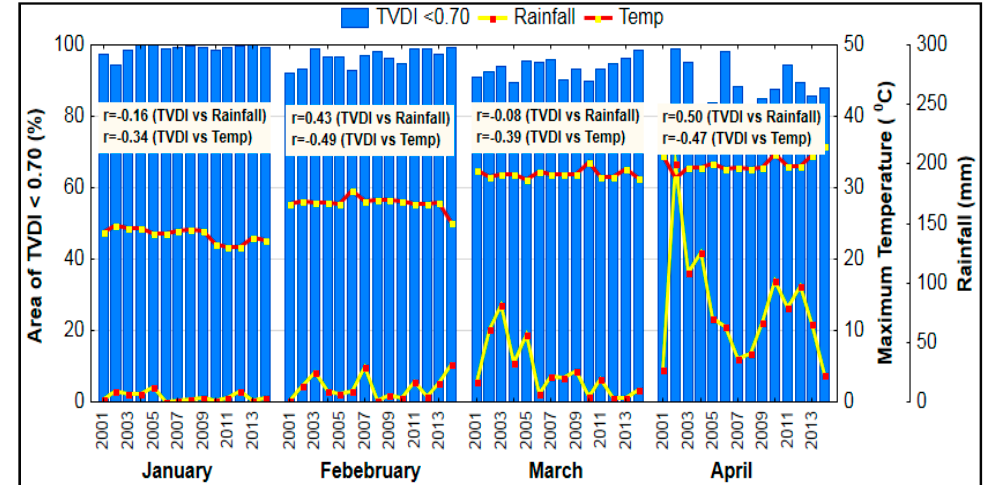
Figure 11. Long-term relationship between lowTVDI and climate variables (temperature and